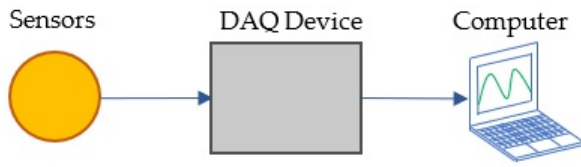
Figure 2. Parts of a data acquisition (DAQ) system.